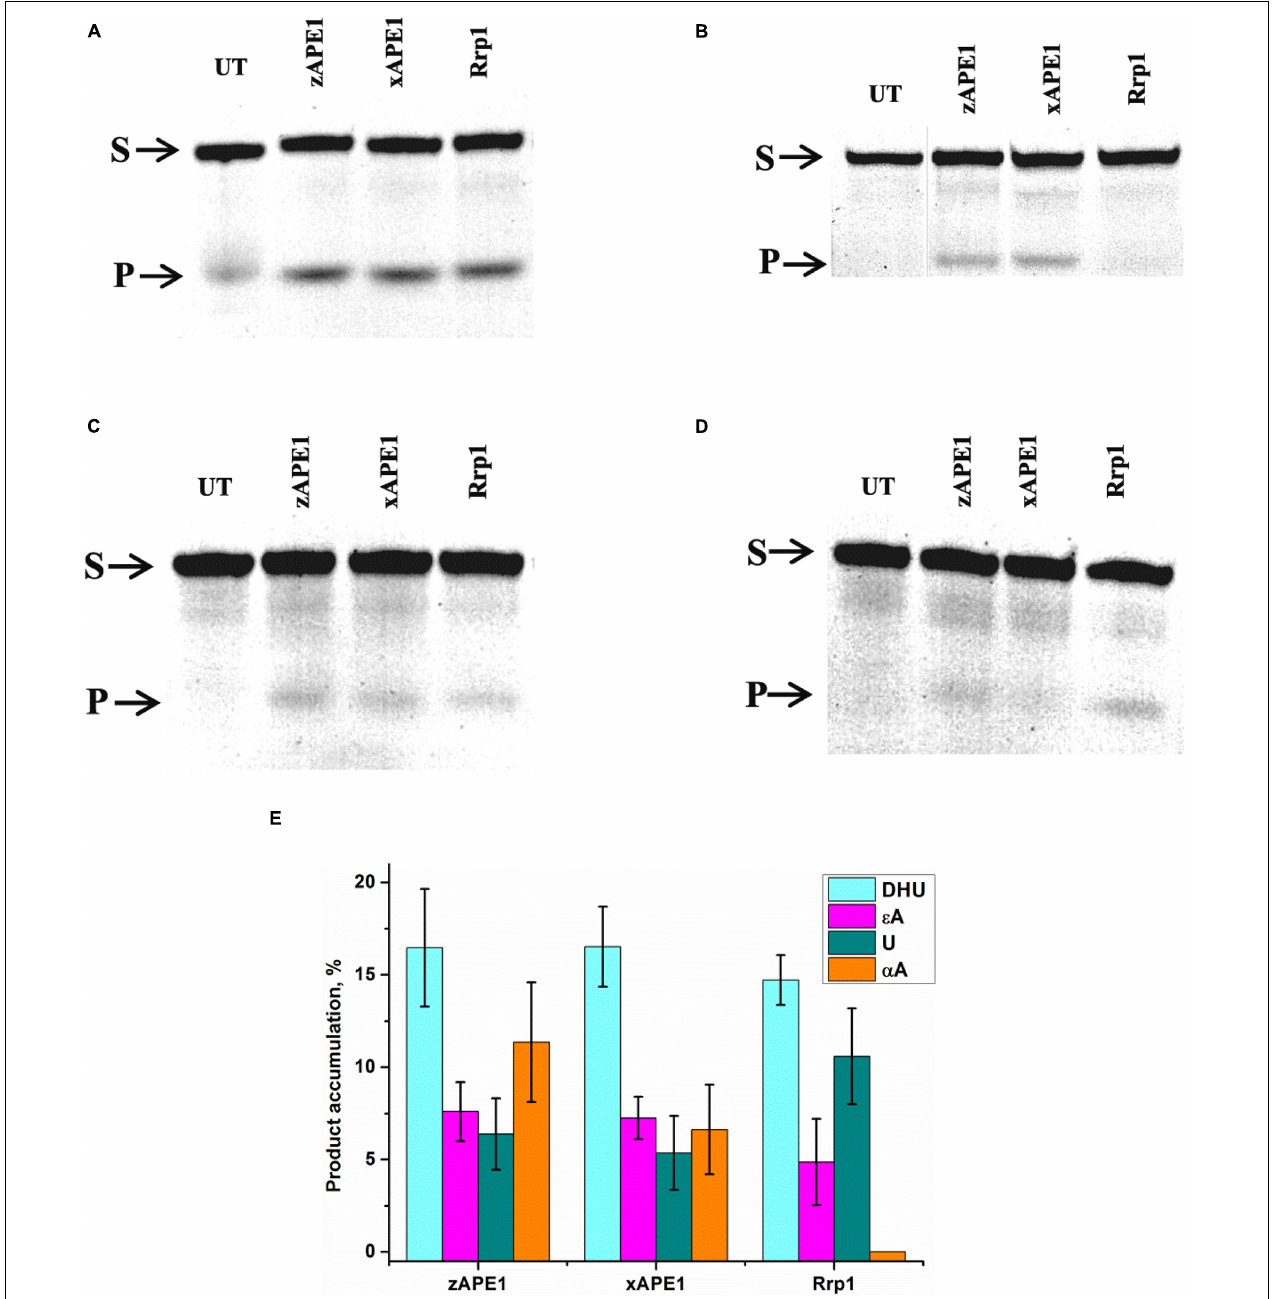
FIGURE 6 | PAGE analysis of DNA cleavage by APE1-like enzymes during an interaction with the FRET–DHU-substrate (A) , FRET– α A-substrate (B) , FRET– ε A-substrate (C) , or FRET-U-substrate (D) . A comparison of efficacy of model DNA substrates’ cleavage by APE1-like enzymes (E) . (Enzyme) = (DNA substrate) = 1.0 µ M. T = 25 ◦ C, reaction time = 2 h. S is a substrate, P is a product of DNA chain cleavage, and UT is a sample untreated with an